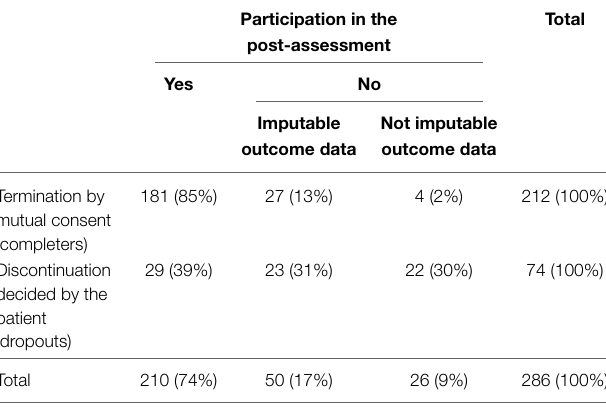
TABLE 1 | Type of termination and amount of missing outcome data in the original sample ( N = 286